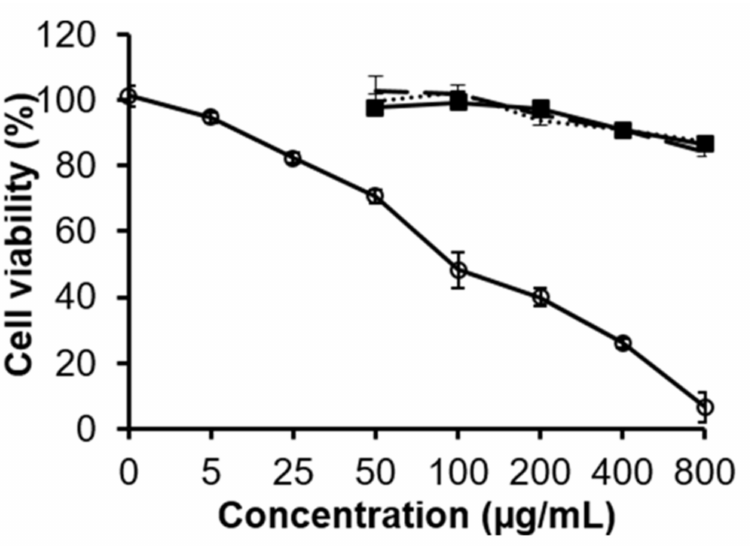
Figure 4. Viability of BJ cells that were exposed to G3.0 (empty circle, solid line), G3.0@mPEG (solid square, solid line), 3TC@G3.0@mPEG (round dot) and AZT@G3.0@mPEG (long dash) solutions within 24 h, calculated by using OD data (n =